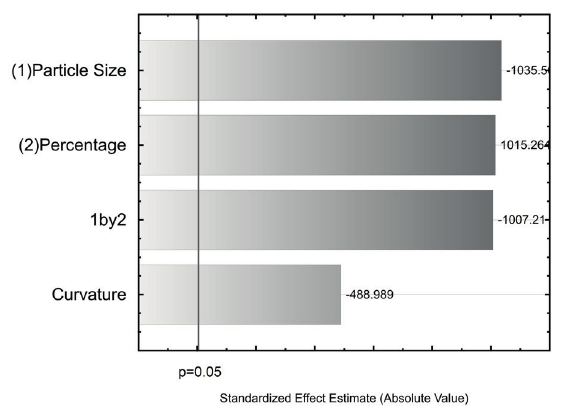
Figure 2 - Amount of CMZ (mg kg -1 ) sorbed into 2 g of soil amended with 1% biochar in particle size < 106 µm (● Soil + Biochar) and into 2 g of pure soil ( ■ Soil), after contact with an herbicide solution (10 mg L -1 ) in function of time